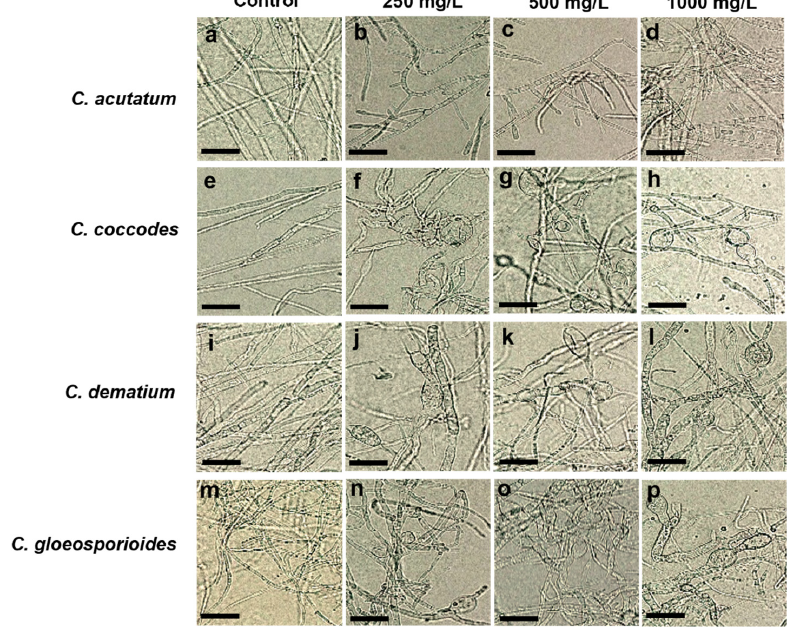
Figure 6. Hyphal deformation of C. acutatum ( b – d ), C. coccodes ( f – h ), C. dematium ( j – l ), and C. gloeosporioides ( n – p ) caused by 250 mg/L, 500 mg/L, and 1000 mg/L of chloroform crude extract of B. velenznesis CE 100 compared to controls ( a , e , i , m ) (scale bar = 25 μ m).